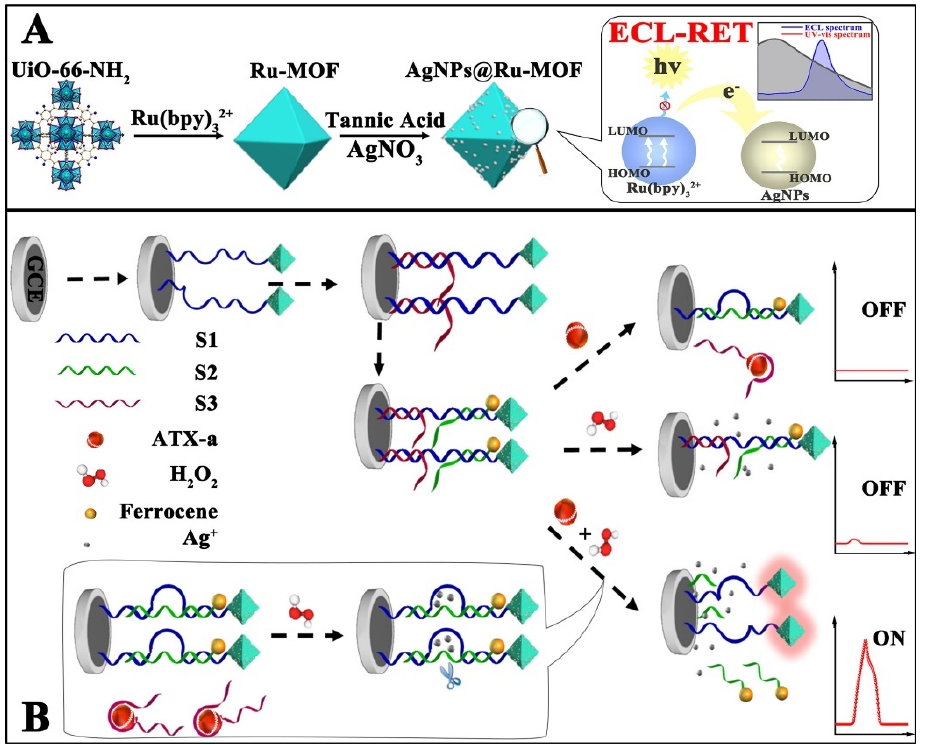
Figure 7. Schematic illustration of in situ generation of AgNPs@Ru-MOF and progress of ECL-RET ( A ), and the response process of ECL-RET aptasensor for ATX-a ( B ) [57]. Copyright © 2021, American Chemical Society.